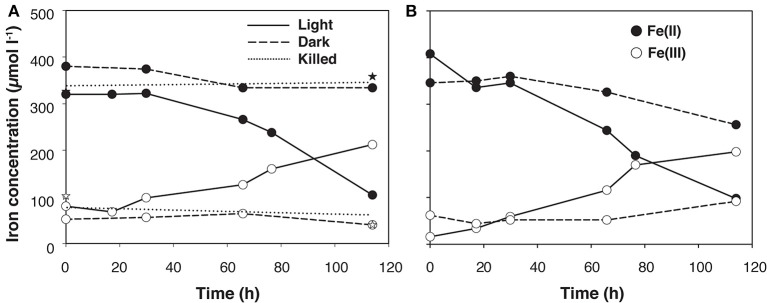
Light-dependent iron-oxidation by the natural microbiota from the anoxic part of the Lake La Cruz chemocline at 11.8 m depth. Anoxic laboratory (ex situ) incubation experiment (11/Feb/2008) (A) without DCMU addition, where oxygenic photosynthesis is active and abiotic Fe(II) oxidation with O2 may occur; and (B) Fe(II) evolution under anoxic conditions in absence of oxygenic photosynthesis (with DCMU addition). For both experimental settings, light conditions involved consecutive periods of 12 h illumination at 61 μE m−2 s−1 and 12 h darkness. Solid symbols stand for Fe(II) and open symbols for Fe(III) concentrations. The dotted lines represent means of killed controls (stars; n = 3).